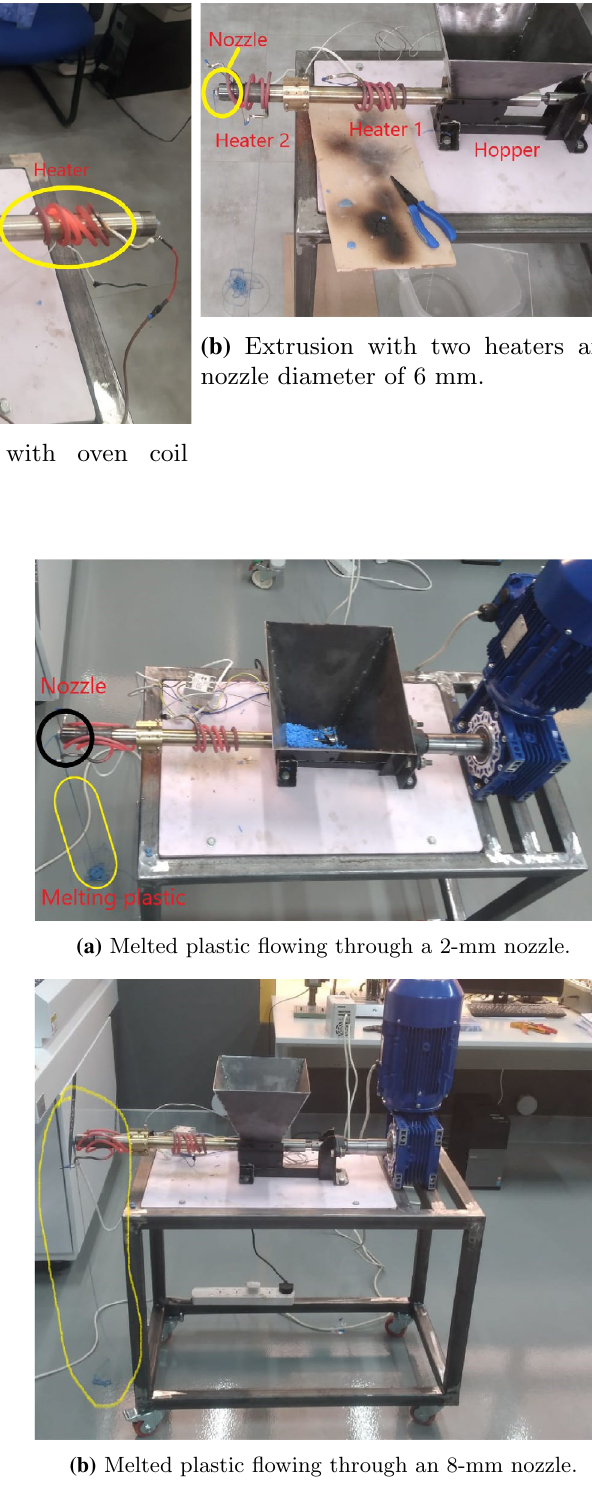
Fig. 16 Melted plastic dripping through the extruder